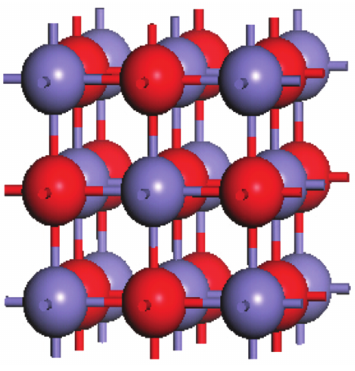
Figure 6: Crystal structure of FeO.